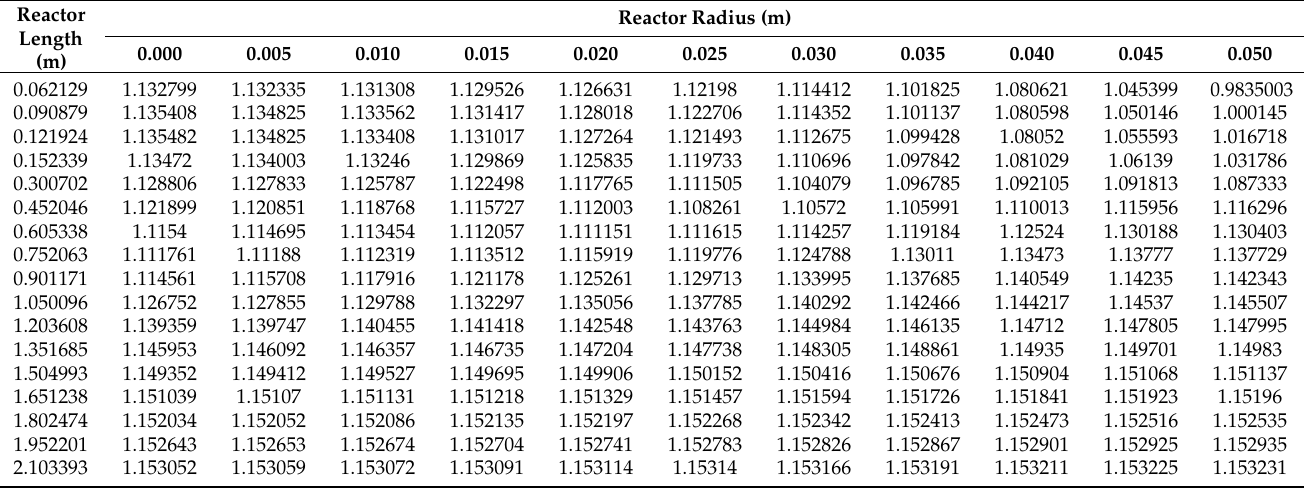
Table A4. Results of the simulation of the effectiveness factor of each particle located at specific points of the radius and length of the reactor. Made with the program particula.pol